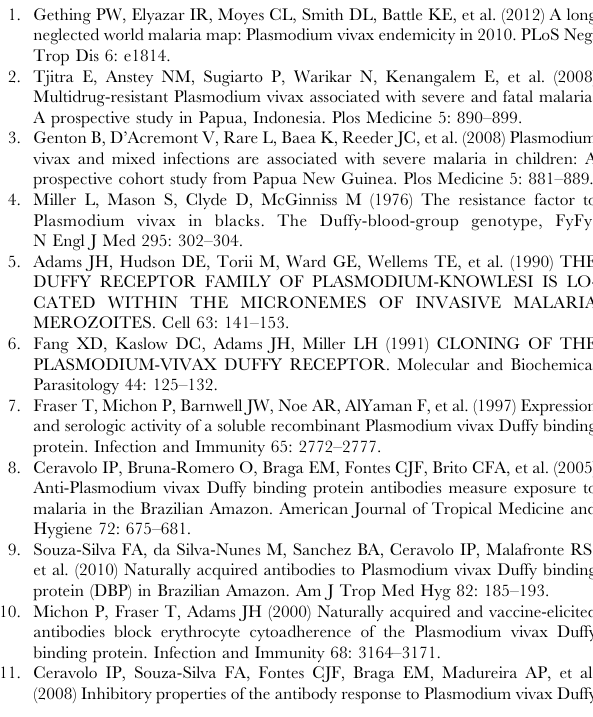
Figure S1 The DBPII binding to erythrocytes is influ- enced by DARC genotype. COS-7 cells, transfected